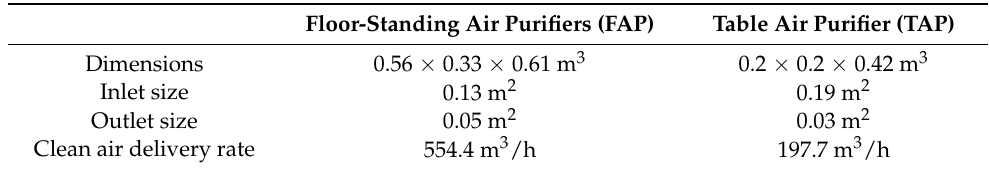
Table 4. Purifier specifications.